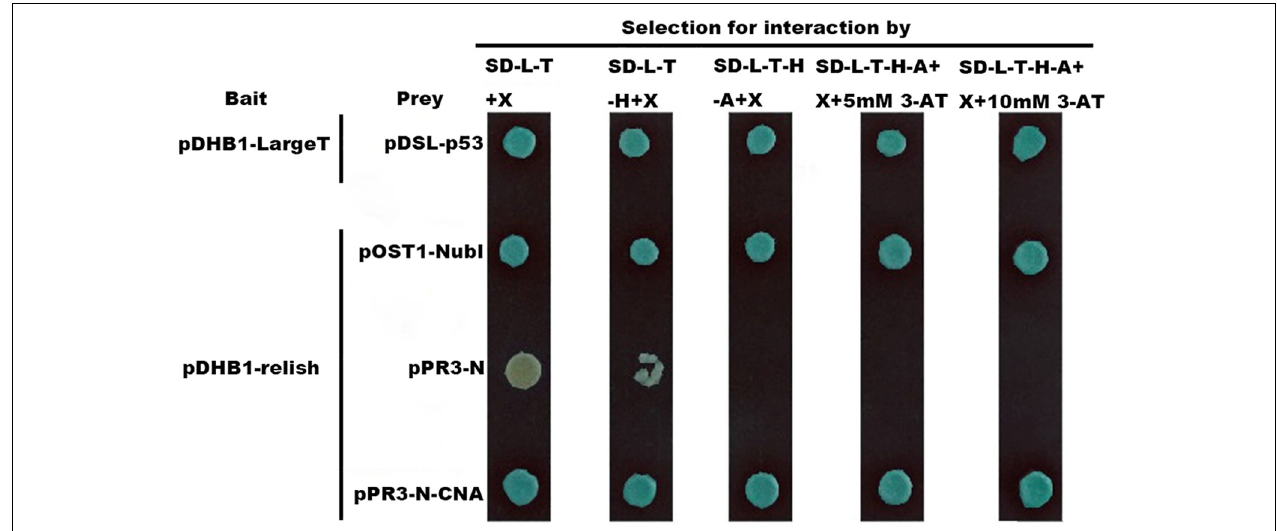
FIGURE 3 | The interactions between HaCNA and Harelish based on yeast two-hybrid system. pDHB1 vector serves as the bait which is fused with the C-terminal half of ubiquitin (Cub) and an artificial transcription factor (LexA-VP6), while in the vector of pPR3-N are fused with the N-terminal half of ubiquitin (NubG, replacement of Ile-13 of wildtype NubI by glycine decreases the affinity between Nub and Cub.). The treatment of pDHB1-LargeT & pDSL-p53 was positive control to show this yeast two-hybrid system works well. SD-L-T + X: SD-Leucine-Tryptophan + 40 mg/L X- α -Gal media (X- α -Gal soluted in N,N-dimethylformamide); SD-L-T-H + X: SD-Leucine-Tryptophan-Histidine + 40 mg/L X- α -Gal media; SD-L-T-H-A + X: SD-Leucine-Tryptophan-Histidine-Adenine + 40 mg/L X- α -Gal media; SD-L-T-H-A + X + 5 mM 3-AT: SD-Leucine-Tryptophan-Histidine-Adenine + 40 mg/L X- α -Gal media + 5 mM 3-AT; SD-L-T-H-A + X + 10 mM 3-AT: SD-Leucine-Tryptophan-Histidine-Adenine + 40 mg/L X- α -Gal media + 10 mM 3-AT.